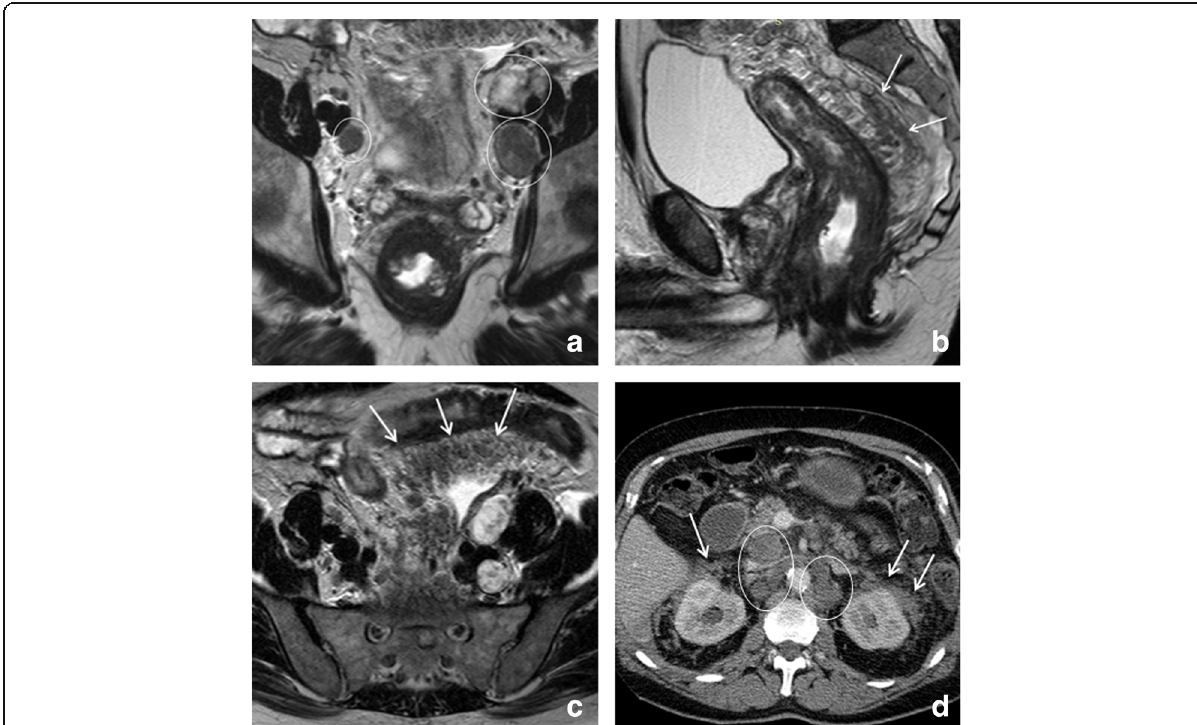
Fig. 6 Signet-ring tumor. Transverse ( a ), sagittal ( b ) and coronal ( c ) T2-weighted MR images, and CT image ( d ) of a male patient with a signet- ring carcinoma of the rectum. Note the typical diffuse hypointense thickening of the rectal wall with extensive tumor infiltration in the mesorectal fat (arrows in b ), that extends all the way up cranially into the mesosigmoidal fat (arrows in c ). There are several large metastatic lymph nodes both in the pelvis (circles in a ) as well as para-aortic in the upper abdomen (circles in d ). At the time of diagnosis, the patient presented with extensive peritoneal metastases (arrows in d ). Palliative chemotherapy was started, shortly after which the patient